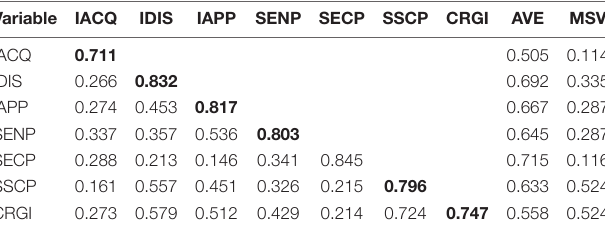
TABLE 2 | Correlation, convergent, and discriminant validity findings. TABLE 3 | Factor loadings of measurements